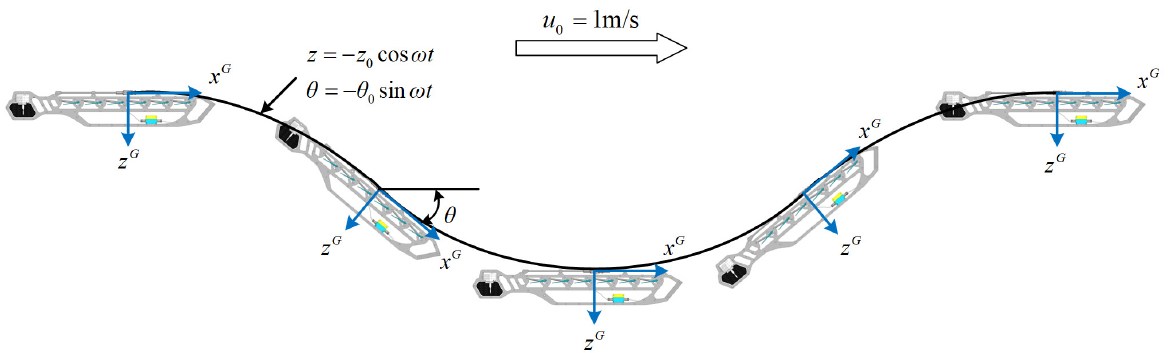
Figure 15. The schematic diagram of the pure pitch test. It is intended to obtain q dependent added mass coefficients and q dependent damping coefficients under different pitching angles of the hydrofoils. The pure pitch motion is defined as: